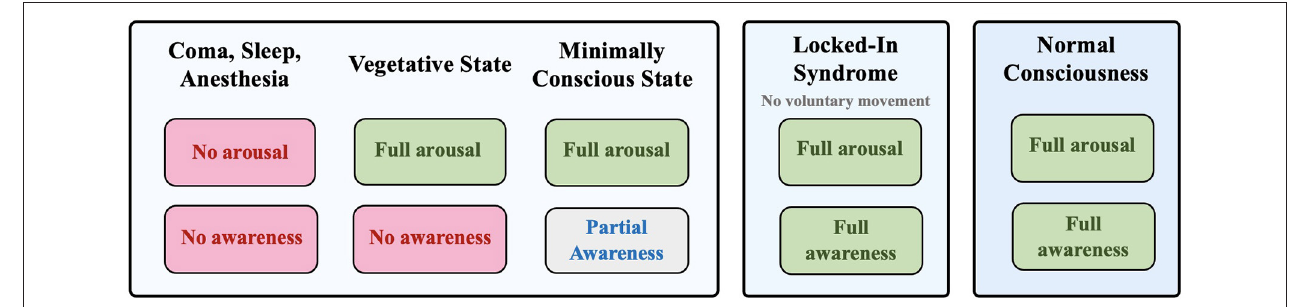
FIGURE 1 | Different states of consciousness: coma, vegetative state, minimally conscious state, locked-in syndrome, and normal consciousness based on the degree of arousal and